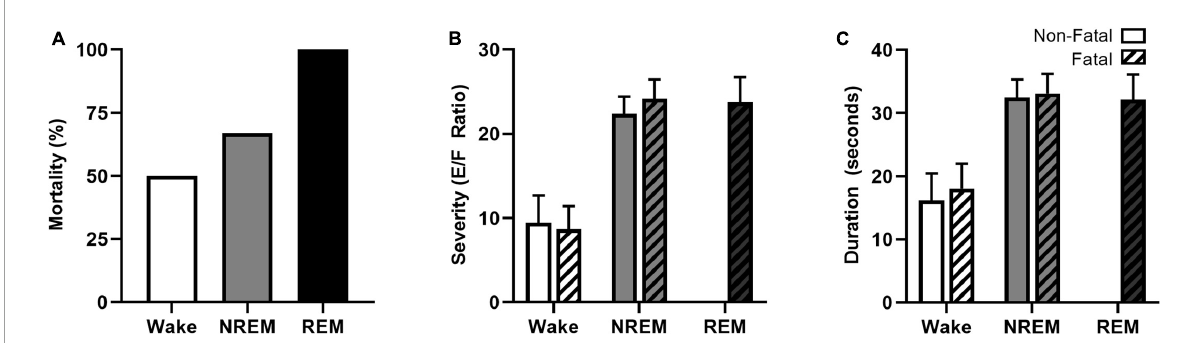
FIGURE4 Vigilance state effects on seizure-induced mortality, severity, and duration. Maximal electroshock-induced seizure mortality exhibits vigilance state-dependence, with 50, 67, and 100% mortality for seizures induced during wakefulness, NREM sleep, and REM sleep, respectively (A) . Seizures induced during NREM and REM were more severe (B) and of longer duration (C) than seizures induced during wakefulness. Figures redrawn with permission from Hajek and Buchanan (2016).